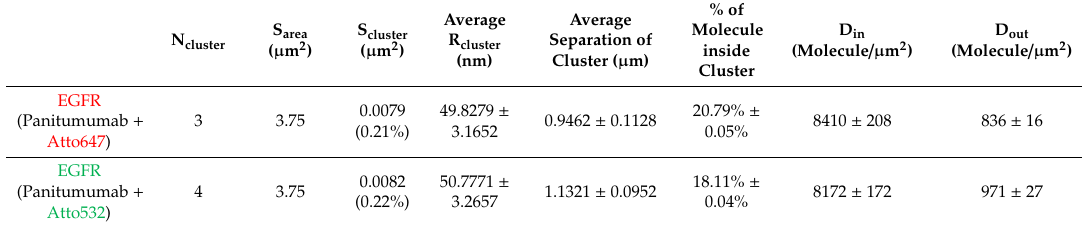
Table 1. A detailed analysis of two-color detections of EGFR clusters at COS7 cell membrane